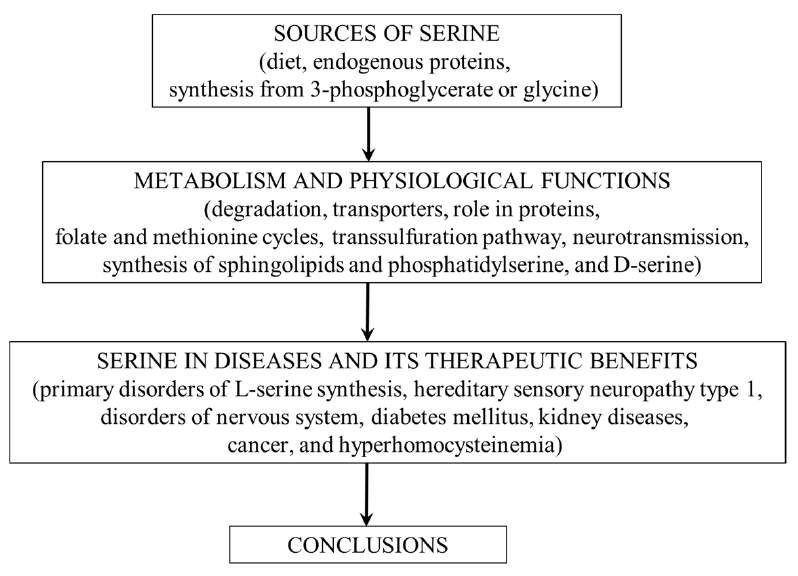
Figure 2. The conceptual framework of the article.